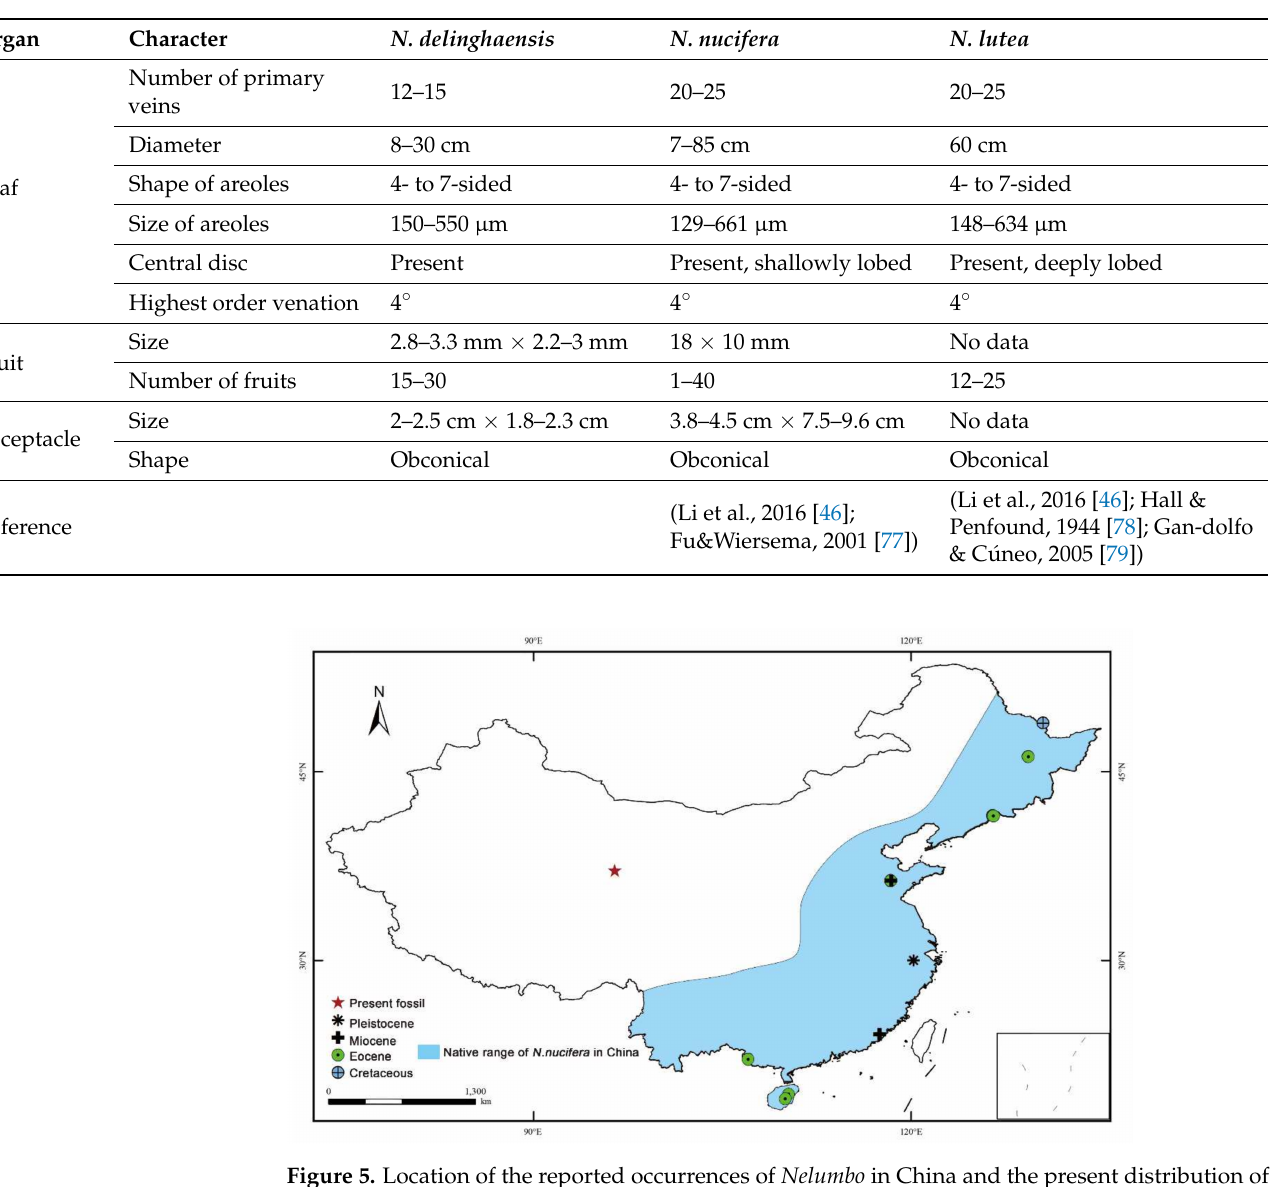
Figure 5. Location of the reported occurrences of Nelumbo in China and the present distribution of Nelumbo in China (modified from Borsch and Barthlott, 1994